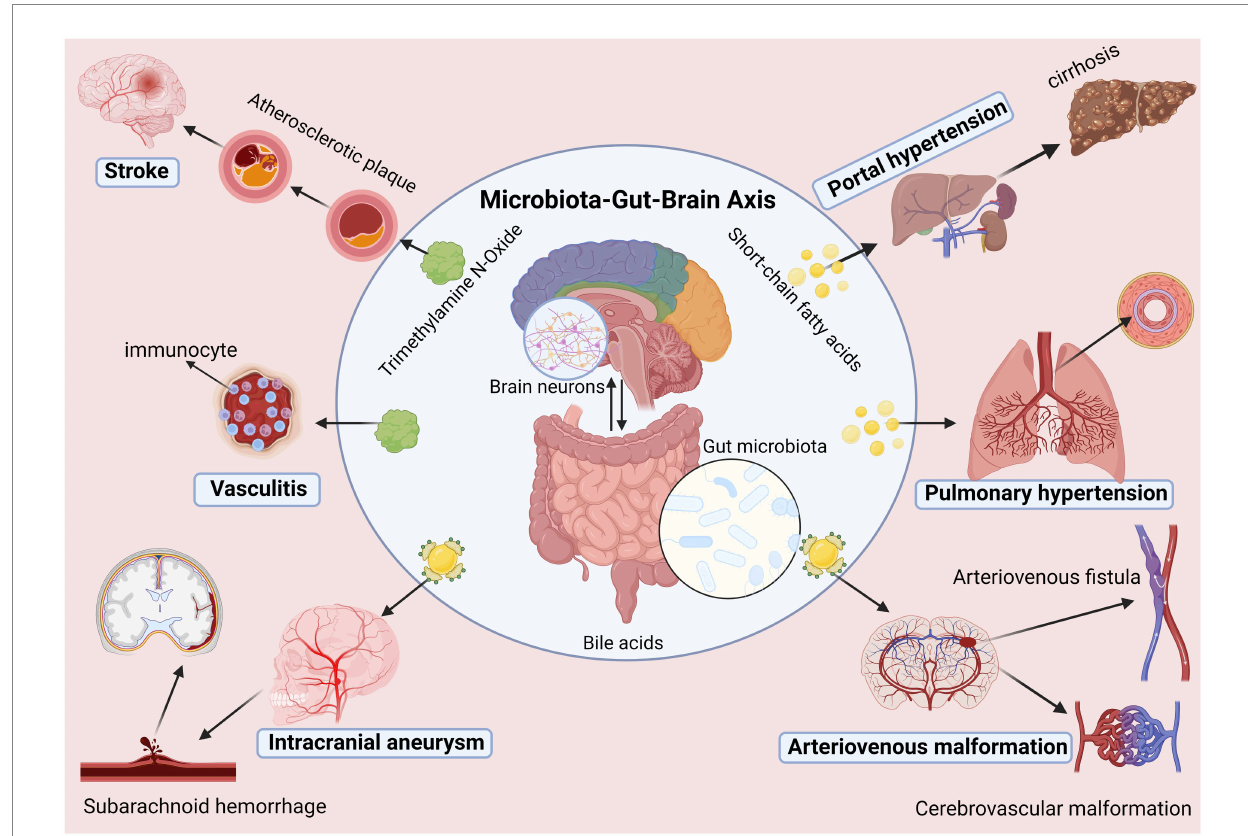
FIGURE 2 Microbiota-gut-brain axis is involved in the occurrence and development of cerebrovascular